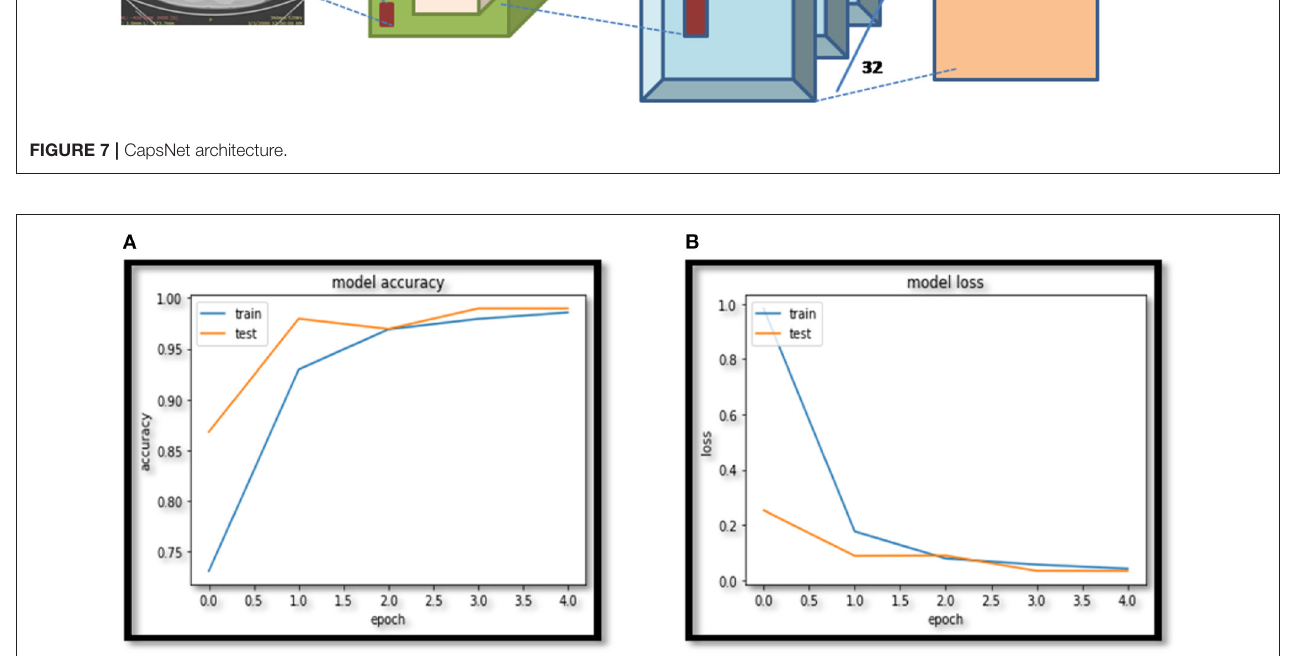
FIGURE 8 | (A) MobileNet accuracy. (B) MobileNet